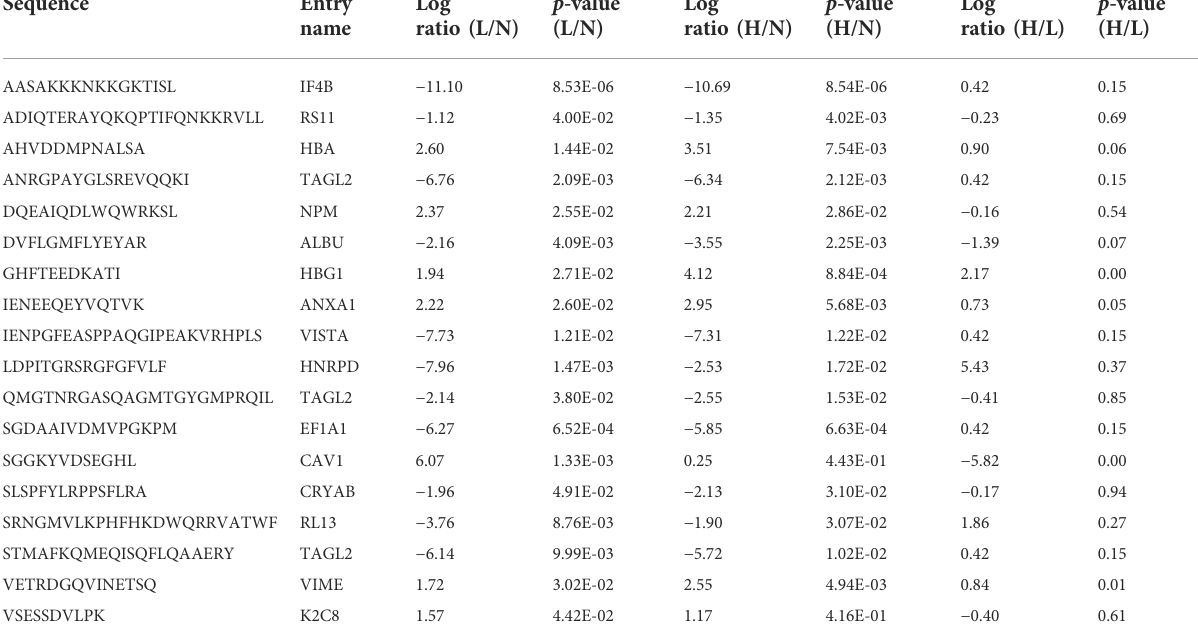
TABLE 1 DEPs both in the comparison of mild PE/control and severe